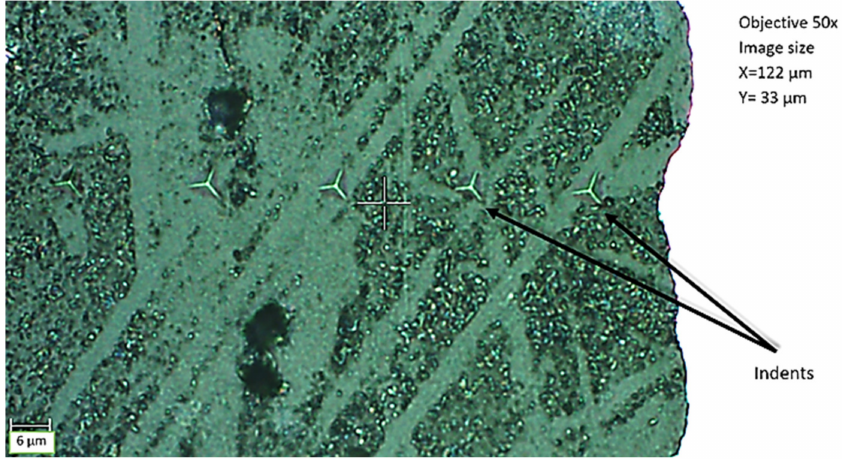
Figure 3. The example of an adhesive bond with visible